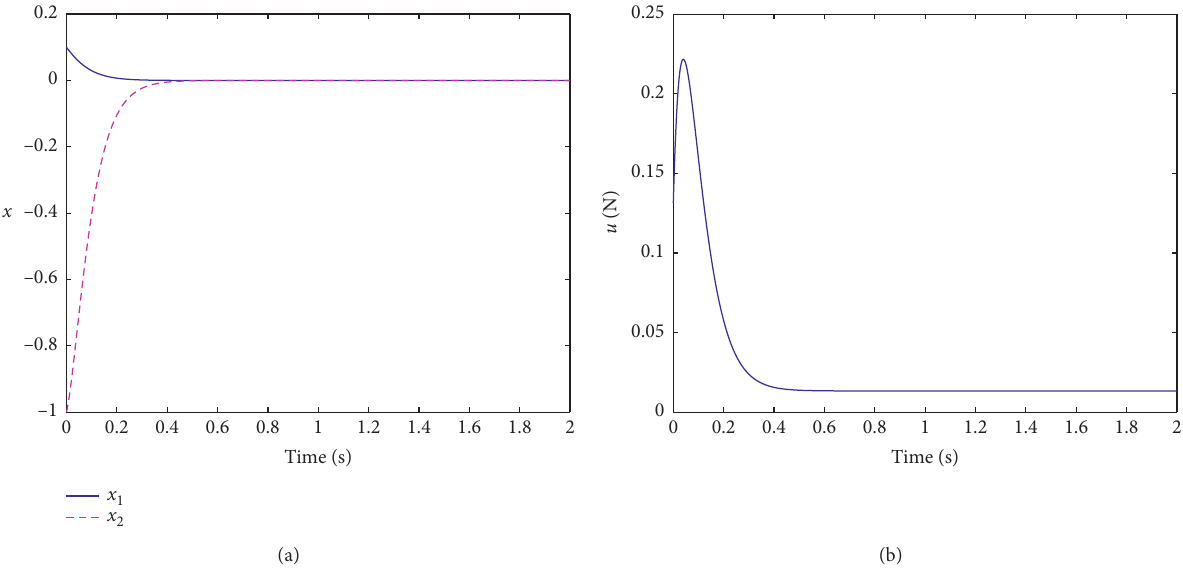
Figure 5: Evolution of the two states, x � 1 in the nominal case. Here, the system is without uncertainties ( δ u max